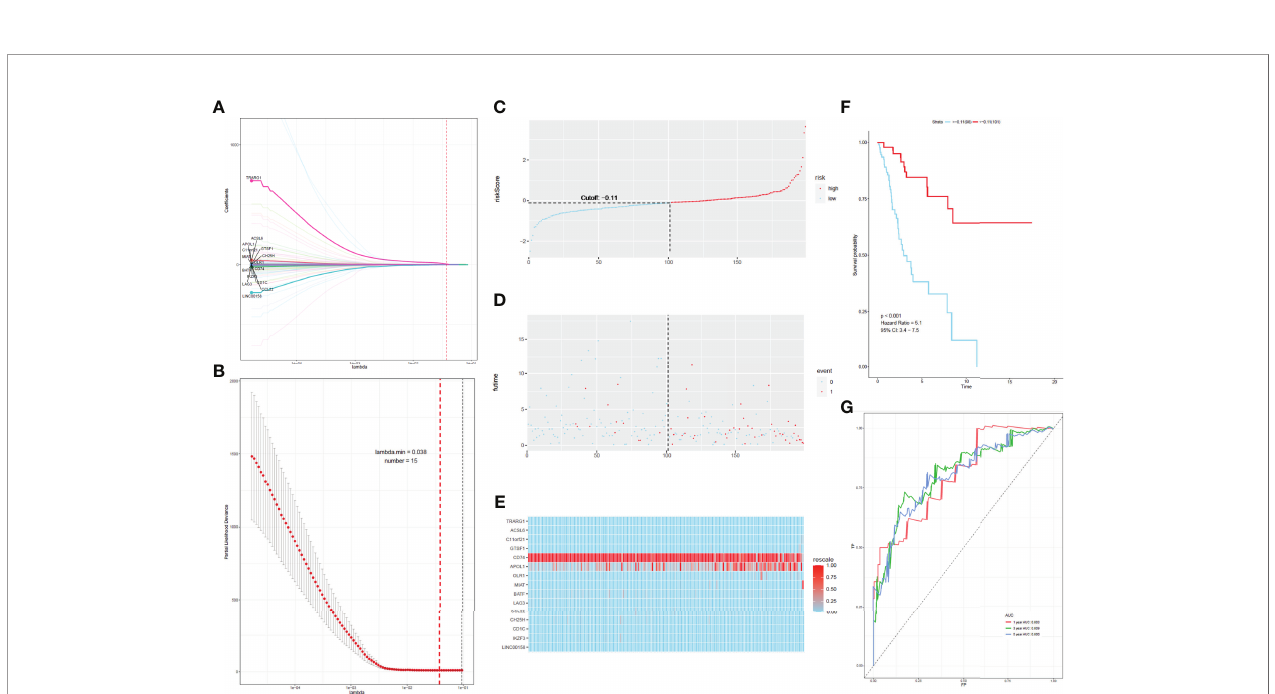
FIGURE 6 | Construction of the prognostic classi fi er. (A, B) Determination of the number of factors by the LASSO analysis. (C) The distribution of risk score in test cohort. (D) The survival duration and status of patients in test cohort. (E) A heatmap of immune related genes in the classi fi er in test cohort. (F) Kaplan – Meier curve for patients with cervical cancer in test cohort. (G) ROC curve for cervical cancer in test